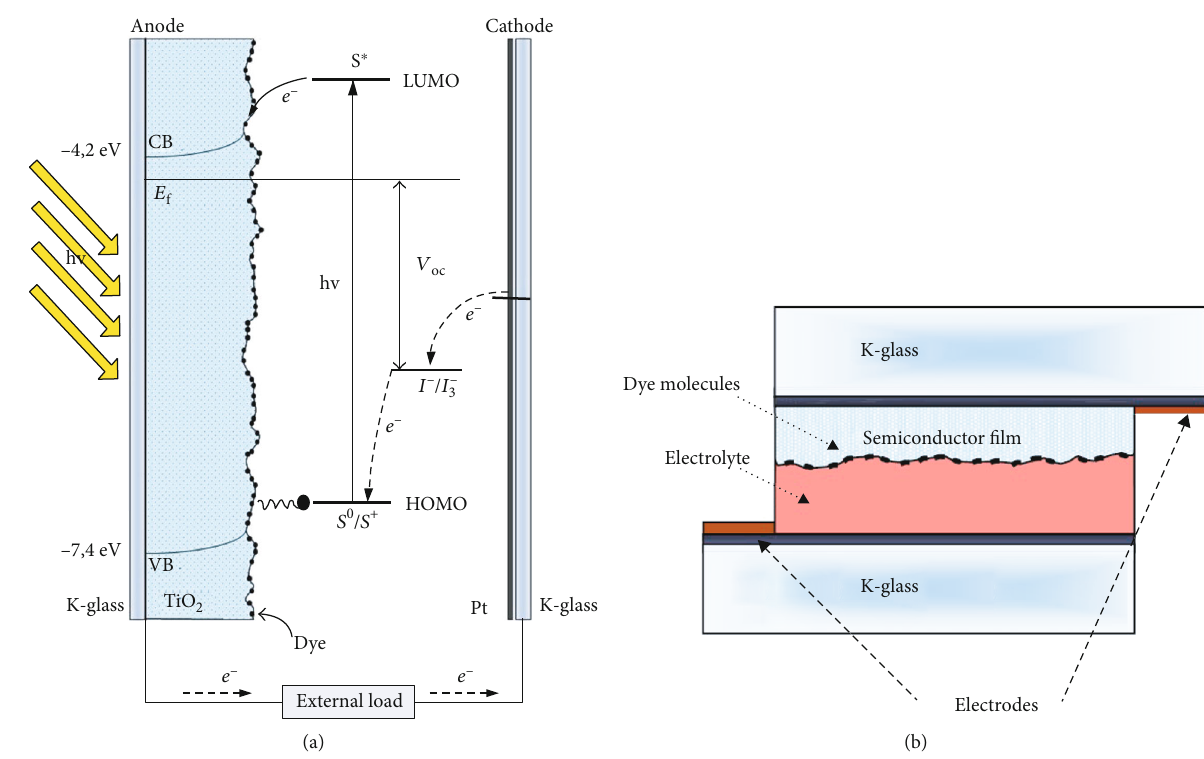
Figure 3: (a) Basic structure of a DSSC [13]. (b) Charge transfer mechanisms in DSSCs